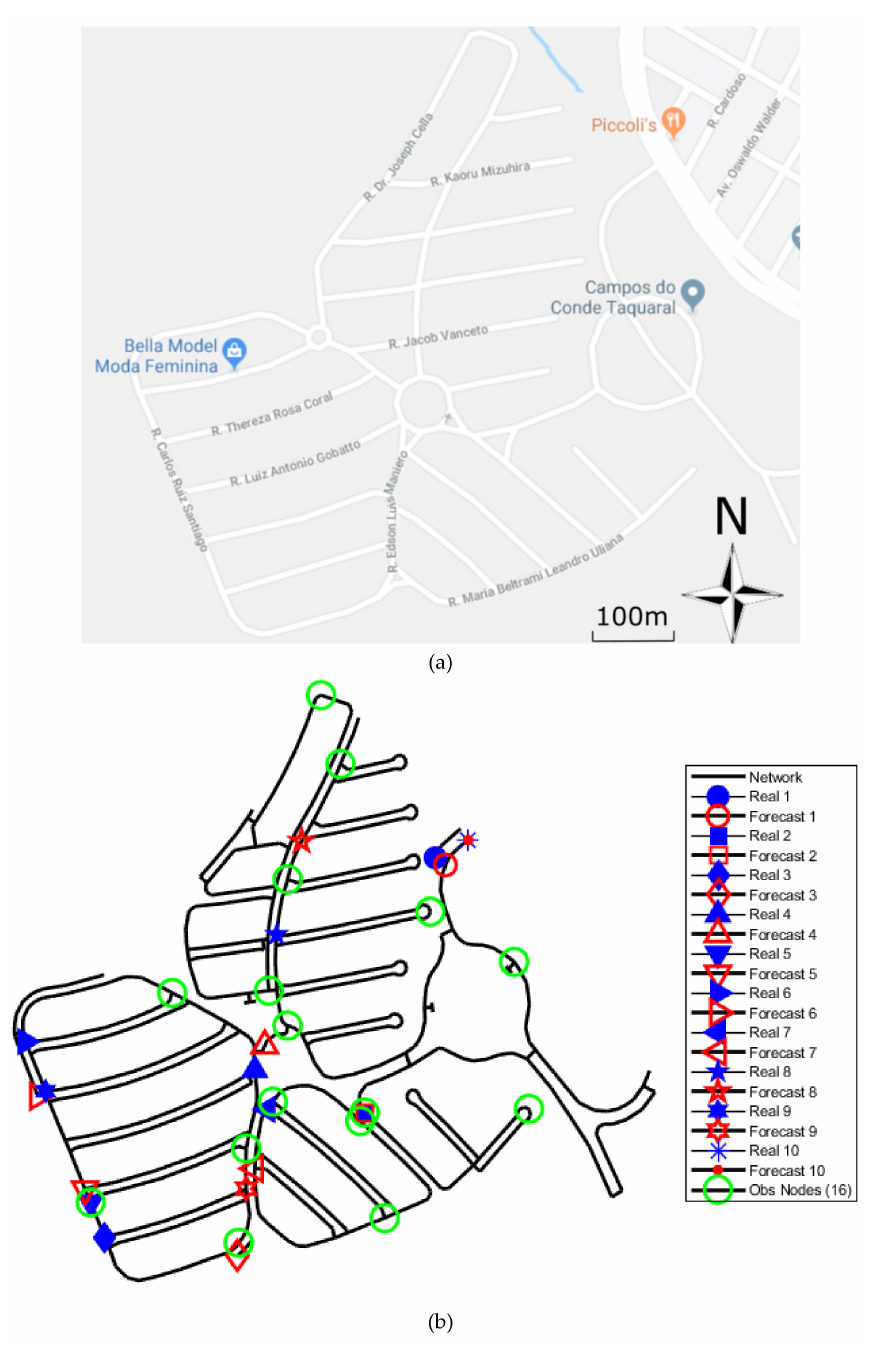
Figure 6. ( a ) Scaled map of the DMA Campos do Conde: adapted from Google Maps ( b ) Results for test scenarios using LOCP method in Campos do Conde